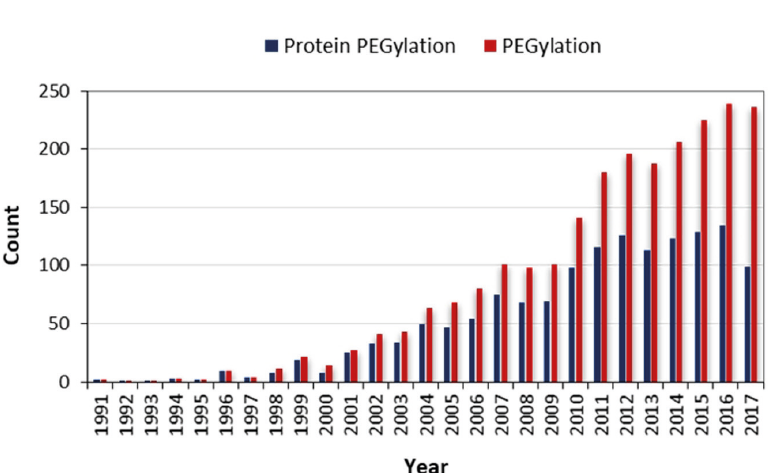
FIGURE 2 - PubMed citations of the title words “ Protein PEGylation ” and “ PEGylation ” in published articles in the last 26 years (from 1991 to